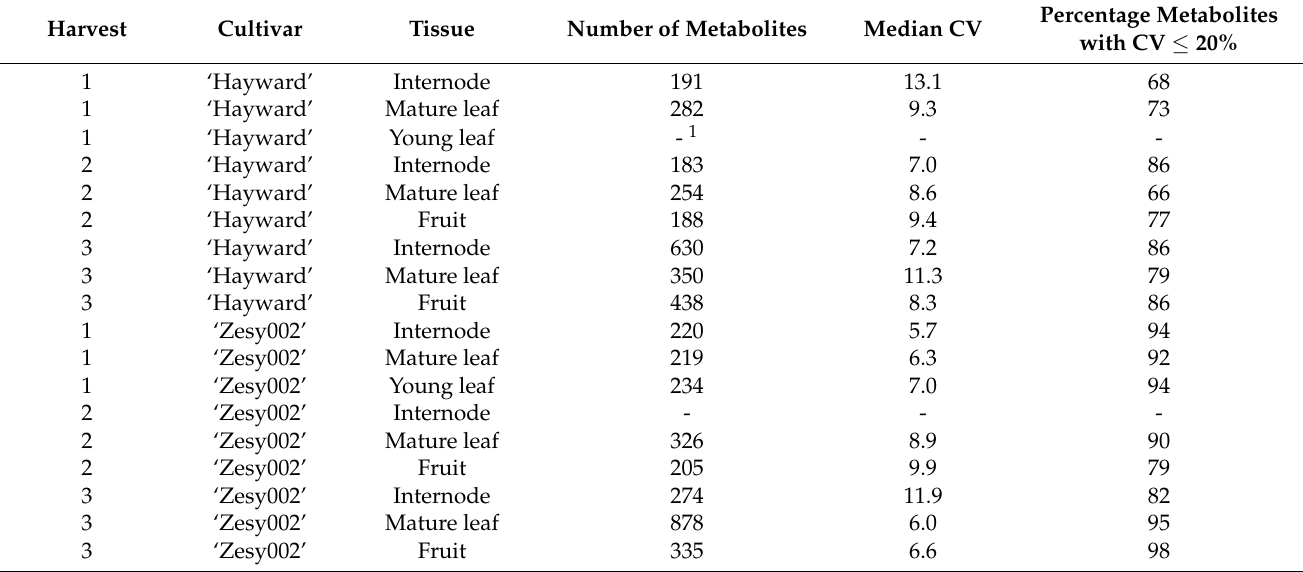
Table 1. Technical replicates: Number of metabolites (mass tags) measured, median %CV and percentage of metabolites with CV < 20% measured in duplicate analyses of powdered or frozen samples from ‘Hayward’ and ‘Zesy002’ kiwifruit vines.